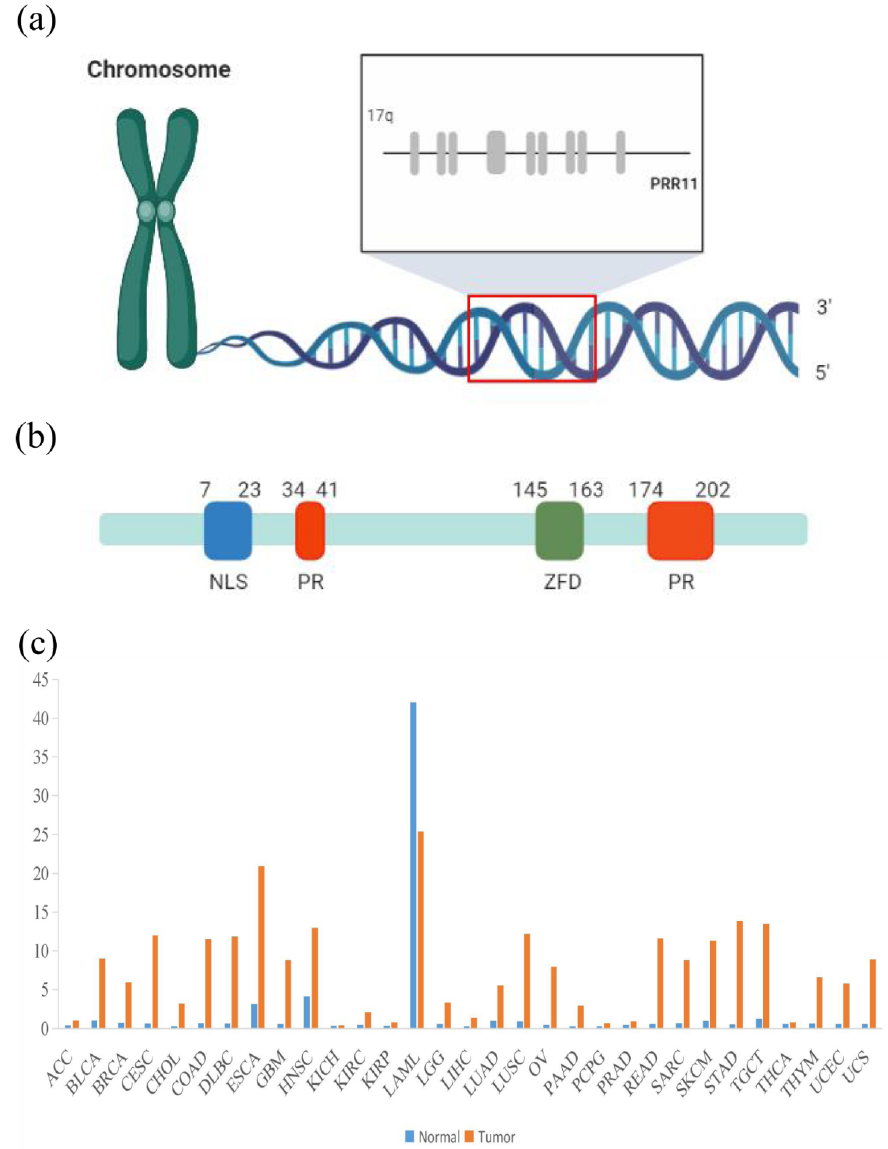
Figure 1. ( a ) Genetic phenotype of PRR11. PRR11 is situated in chromosome 17q22-23 with ten exons and nine introns. ( b ) Proteomics of PRR11. PRR11 consists of a nuclear localization signal (NLS), two proline rich regions (PRs) and a zinc finger domain (ZFD). ( c ) The expression level of PRR11 in multiple human cancers in the GEO database. Abbreviations: PRR11 , proline rich 11; NLS , nuclear localization sequence; PR , proline rich region; ZFD , zinc finger domain; ACC , adrenocor- tical carcinoma; BLCA , bladder carcinoma; BRCA , breast carcinoma; CESC , cervical squamous cell carcinoma; CHOL , cholangiocarcinoma; COAD , colon adenocarcinoma; DLBC , diffuse large B-cell lymphoma; ESCA , esophageal carcinoma; GBM , glioblastoma; HNSC , head and neck squamous cell carcinoma; KICH , kidney chromophobe; KIRC , kidney renal clear cell carcinoma; KIRP , kidney renal papillary cell carcinoma; LAML , acute myeloid leukemia; LGG , low grade glioma; LIHC , liver hepatocellular carcinoma; LUAD , lung adenocarcinoma; LUSC , lung squamous cell carcinoma; OV , ovarian serous cystadenocarcinoma; PAAD , pancreatic adenocarcinoma; PCPG , pheochromocytoma and paraganglioma; PRAD , prostate adenocarcinoma; READ , rectum adenocarcinoma; SARC , sar- coma; SKCM , skin cutaneous melanoma; STAD , stomach adenocarcinoma; TGCT , testicular germ cell tumors; THCA , thyroid carcinoma; THYM , thymoma; UCEC , uterine corpus endometrial carcinoma; UCS , uterine